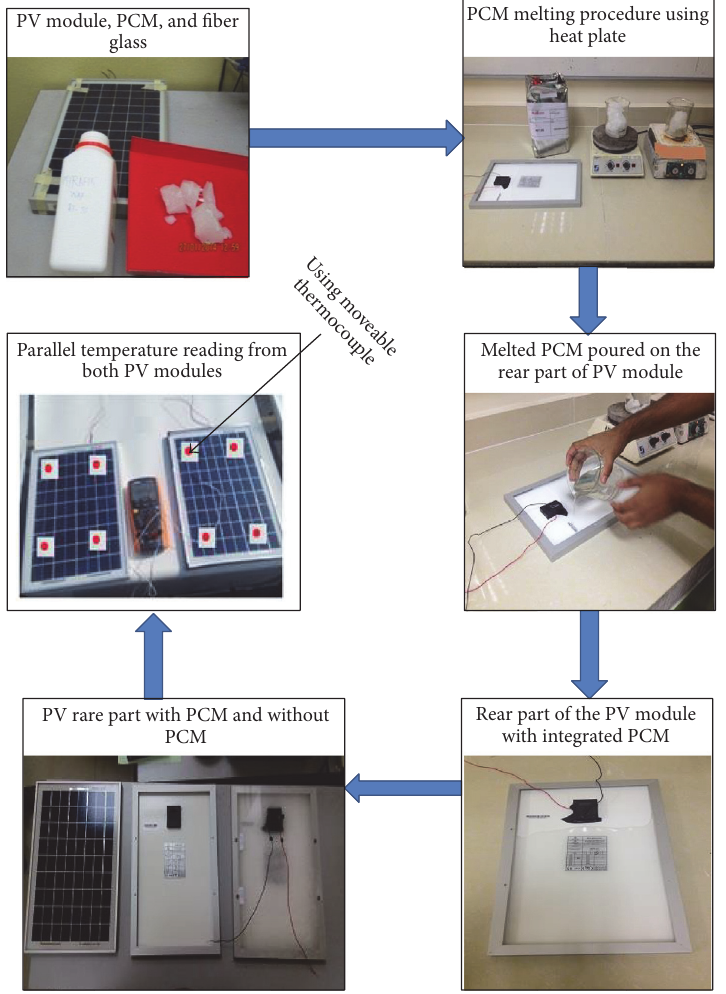
Figure 4: Development of the complete experimental